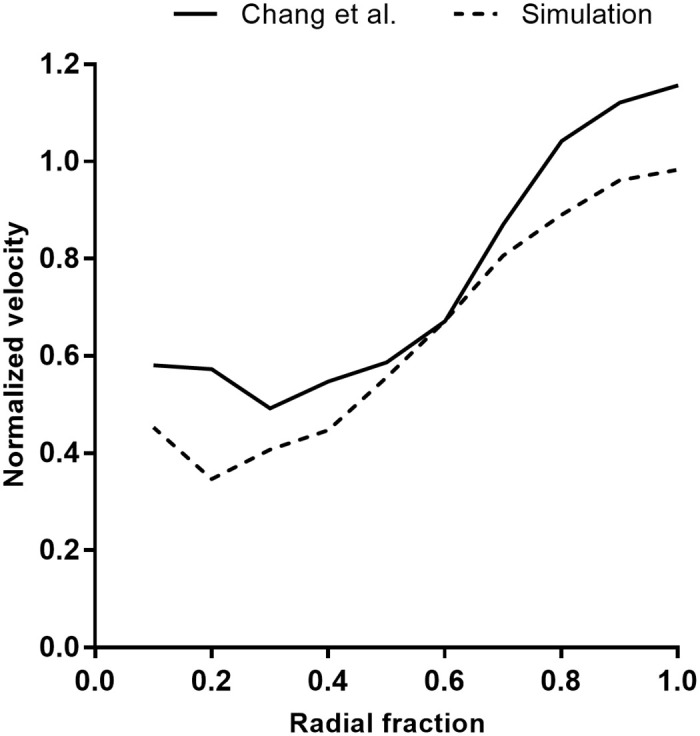
Comparison of normalized mean shell velocity between an experiment and the present simulation.The mean shell velocity is plotted as a function of radial distance from the center of the colony to the exterior and normalized by the oncoming velocity magnitude. The difference in the mean shell velocity profiles may be due to the difference in the structures’ branch distance to branch diameter ratios, which are reported in Table 1. The experimental data is obtained by magnetic resonance velocimetry in a S. pistillata colony [31]. Reproduced with permission from Limnology and Oceanography 54, 1819 (2009). Copyright 2009 by John Wiley and Sons, Inc.